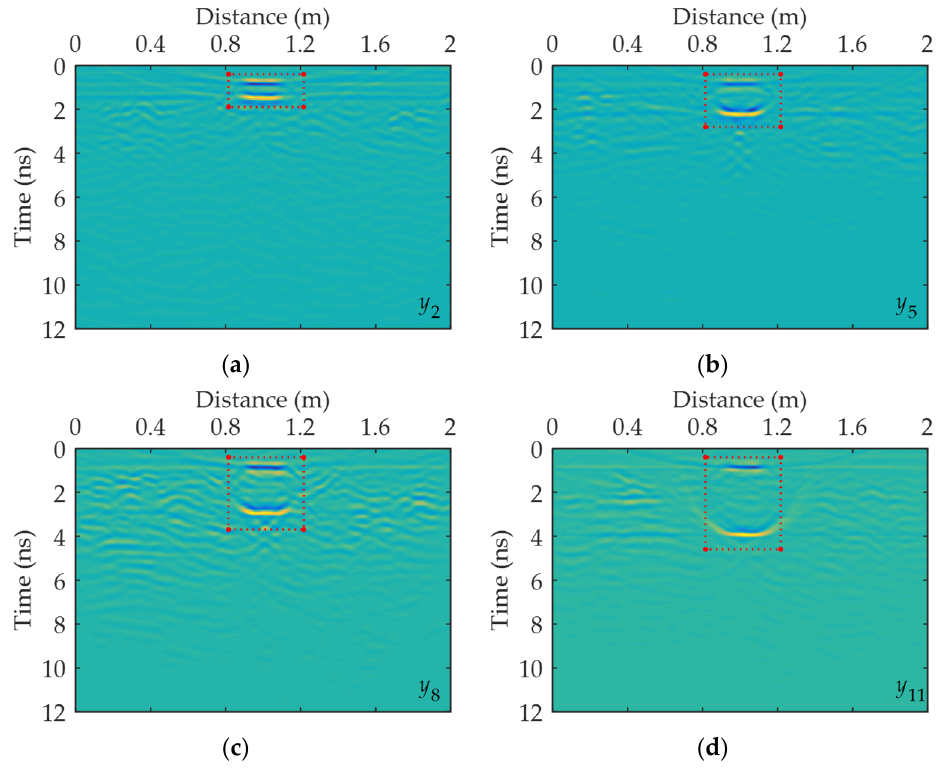
Figure 8. GPR profiles of four horizontal survey lines after conventional processing: ( a ) survey line y 2 ; ( b ) survey line y 5 ; ( c ) survey line y 8 ; ( d ) survey line y 11 .